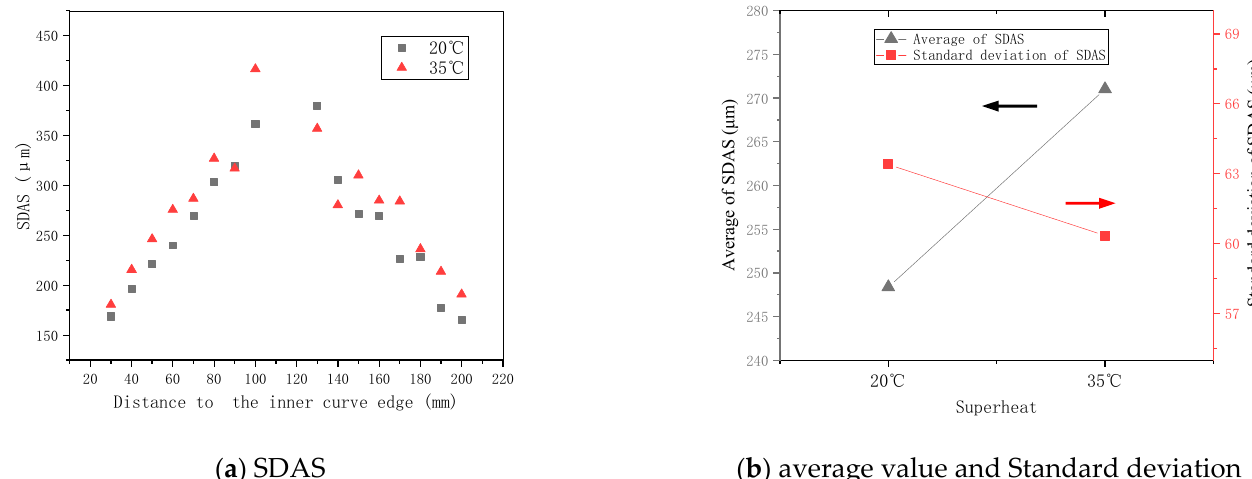
Figure 20. Secondary arm spacings (SDASs) at different locations and corresponding average values under 20 and 35 °C.